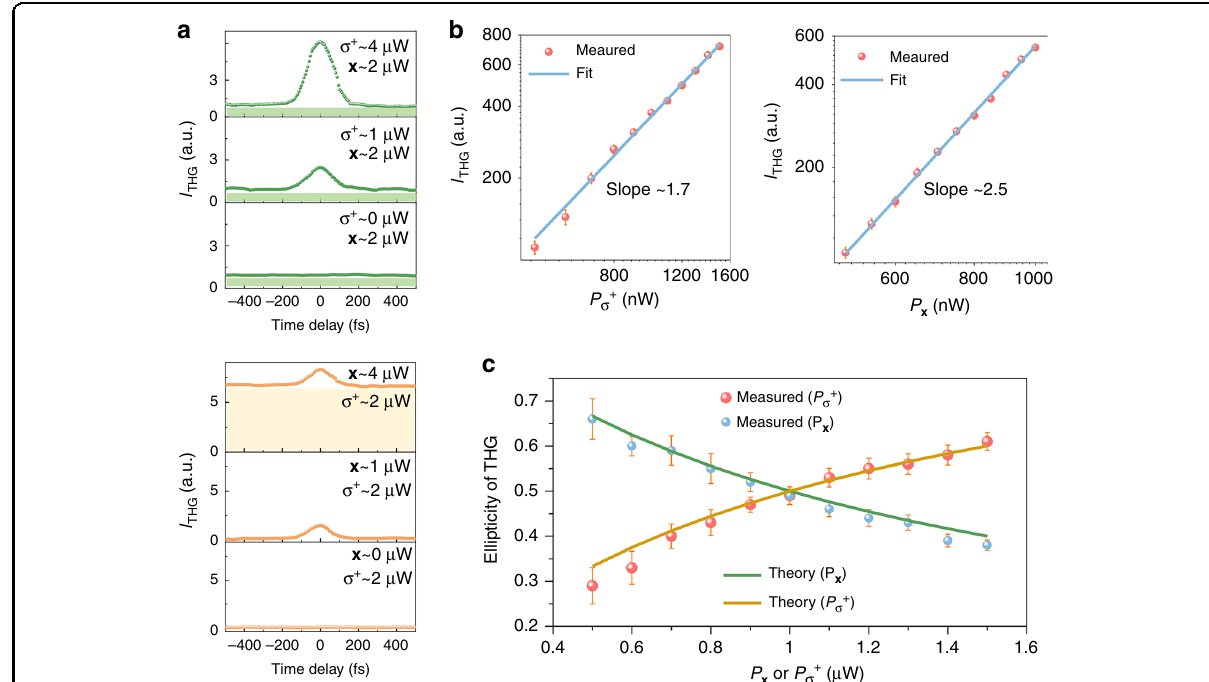
Fig. 4 THG modulation performance in monolayer MoS 2 with a linearly- and a circularly-polarized input beam (Case 2). a Modulated THG signal as a function of the time delay under different incident powers (upper panel: the power of the linearly polarized beam is fi xed; lower panel: the power of the circularly polarized beam is fi xed). b THG power dependence on the σ + circularly- (linearly-) polarized beam while the power of the other beam with the linear ( σ + circular) polarization is ~1 μ W. c THG ’ s ellipticity dependence on the σ + circularly- or linearly-polarized beam while the power of the linearly- ( σ + circularly-) polarized beam is ~1 μ W. Note that the measured average power of the incident beam is proportional to m 2